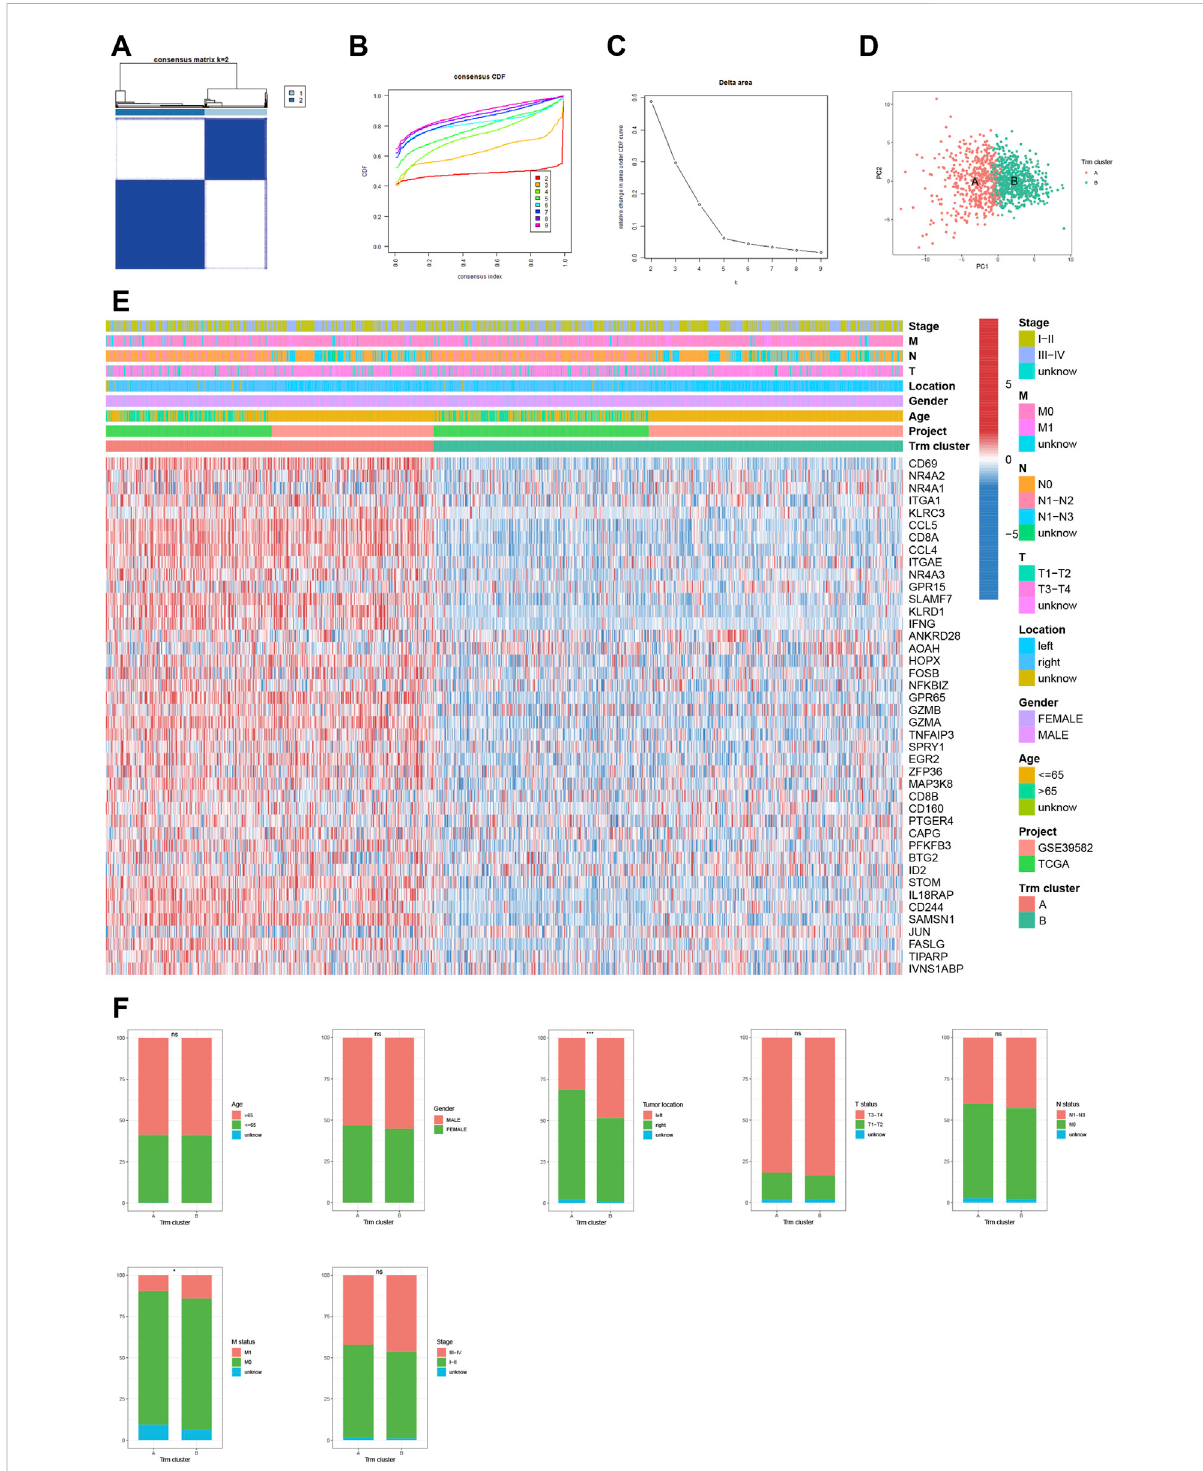
FIGURE 2 Identi fi cation of Trm clusters in CRC patients. (A) Consensus matrix heatmap showing two Trm clusters. (B) CDF curve, (C) k-mean algorithm and (D) PCA analysis showing the robustness and stability of the clustering. (E) Heatmap showing the expression pattern of Trm marker genes in two clusters. (F) Bar plots showing the correlation of Trm clusters with clinicopathological factors including age, gender, tumor location, T, N, M status and tumor stage. CDF: Cumulative distribution function; PC: Principal component. Statistical Signi fi cance: * p < 0.05; *** p < 0.001; ns: not signi fi